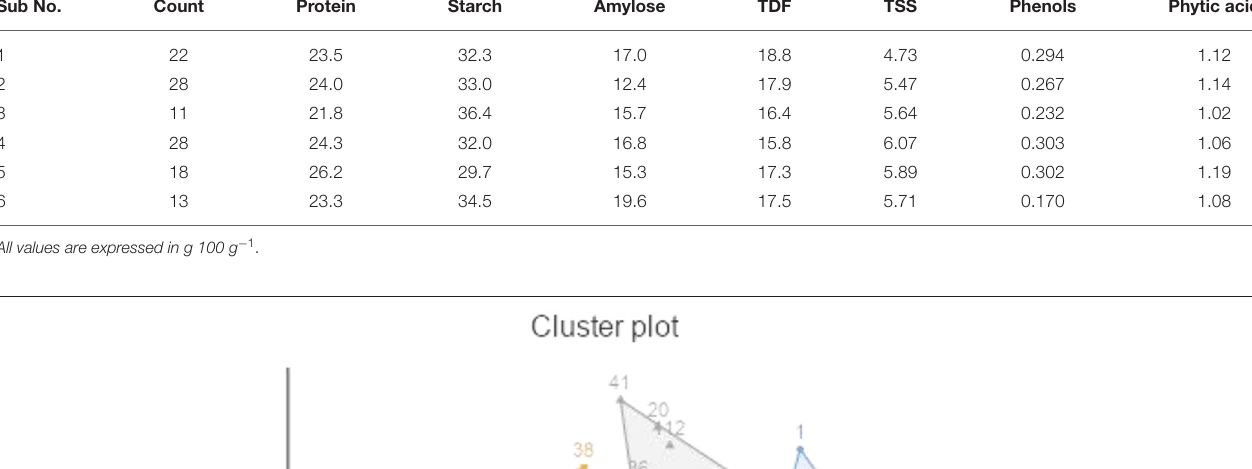
and EC472284 (cluster III) can be used for this purpose owing to their high starch content. Except for EC240663, the other two accessions also have high amylose and high TDF